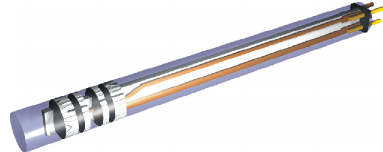
Fig.6: Tetrapolar interface consisting of four stainless steel rings with a diameter of 6 mm. The electrode system is molded in PMMA (poly-methylene-methacrylate).